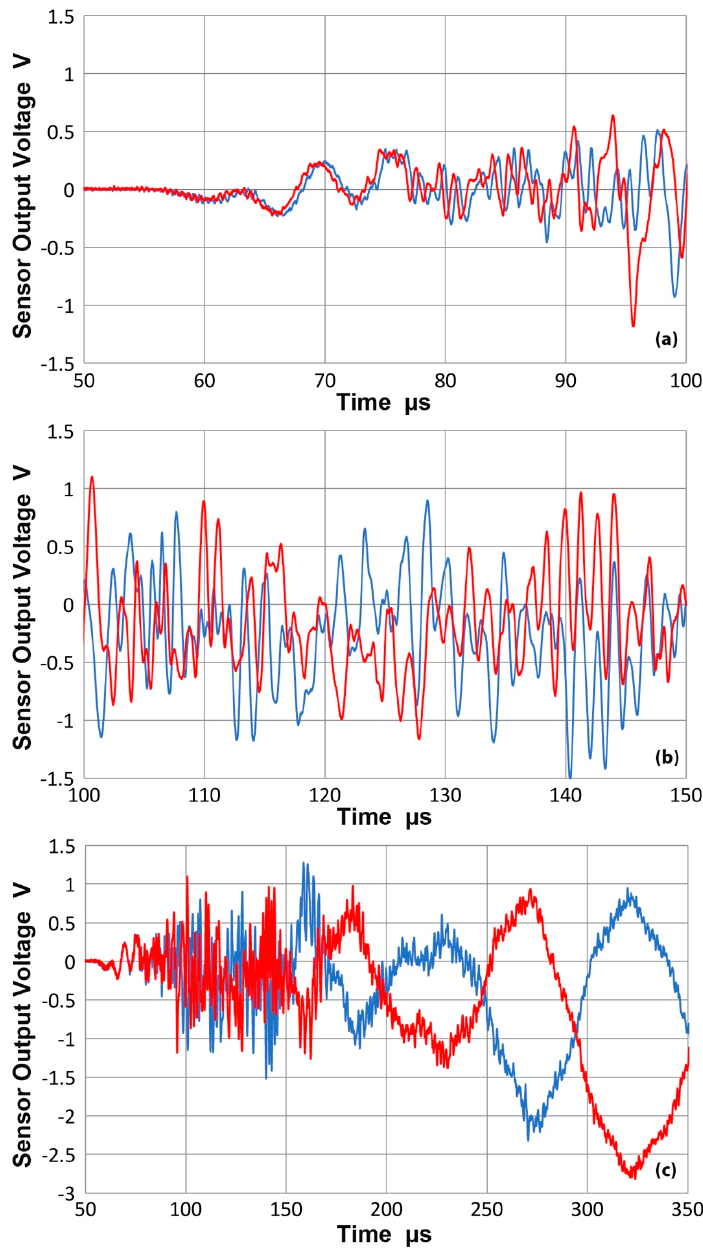
Figure A2. ( a ) The received waveforms from asymmetric excitation method on opposite surfaces using a KRN sensor (#11063 with FET buffer) at 300 mm from the transmitter. From 50 to 100 µs. Compare to Figure 7; ( b ) Same as ( a ), but for 100 to 150 µs; ( c ) Same as ( a ), but for 50 to 350 µs.